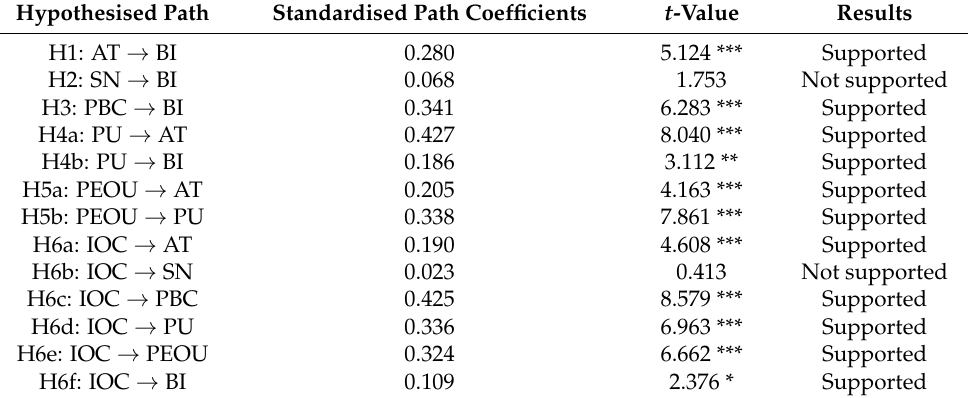
Table 8. Hypotheses test